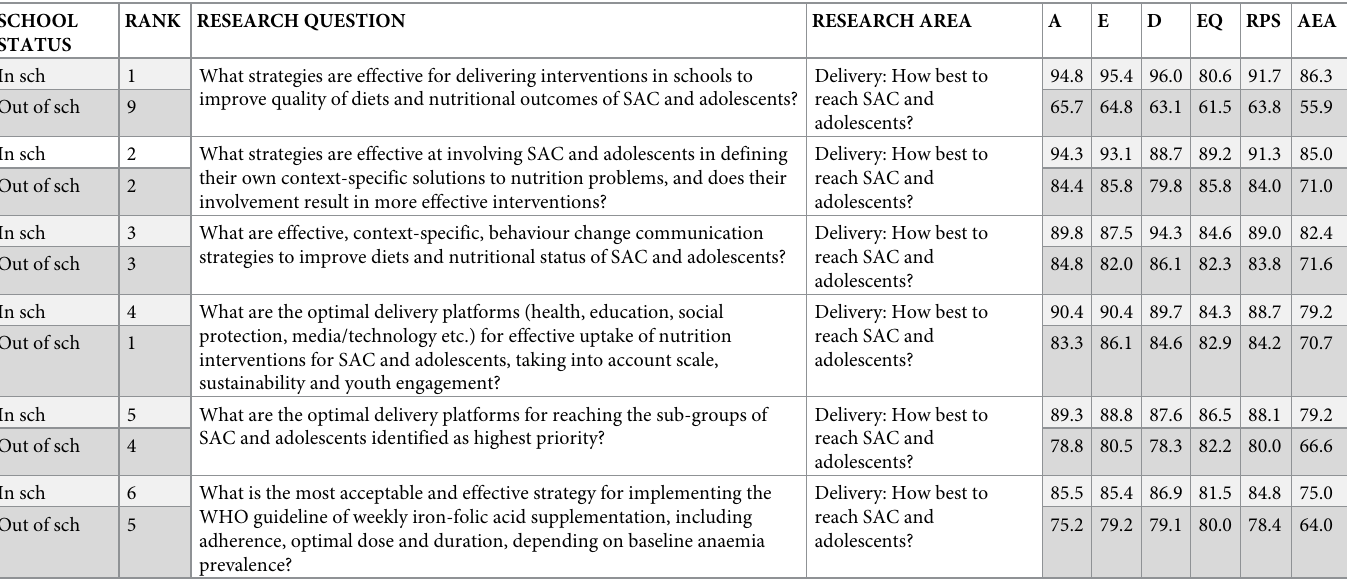
Table 4. Top five ranked research questions disaggregated for those in- and out-of-school.